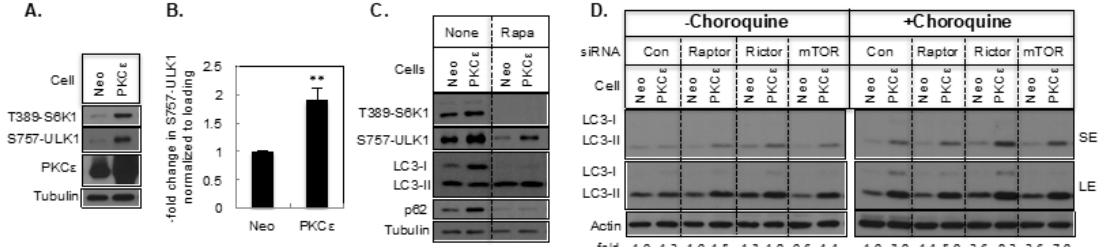
Figure 6. The effect of PKC ε overexpression and mTOR signaling on autophagy. ( A ) Western blot analysis was performed with MCF-7/Neo and MCF-7/PKC ε cells. ( B ) Bar graph represents mean ± S.E. **, p ≤ 0.005 ( n = 10). ( C ) Effect of Rapamycin on LC3-I, LC3-II and p62. Cells were treated with or without 100 nM Rapamycin and Western blot analysis was performed. ( D ) MCF-7/Neo and MCF-7/PKC ε cells were transfected with control non-targeting, Raptor, Rictor or mTOR siRNA and then treated with or without 10 µM chloroquine for 2 h. Western blot analyses were performed with indicated antibodies. Actin was used to control for loading differences. SE, short exposure; LE-long exposure. The fold change in LC3-II with respect to control and normalized with loading is indicated below the Figures.